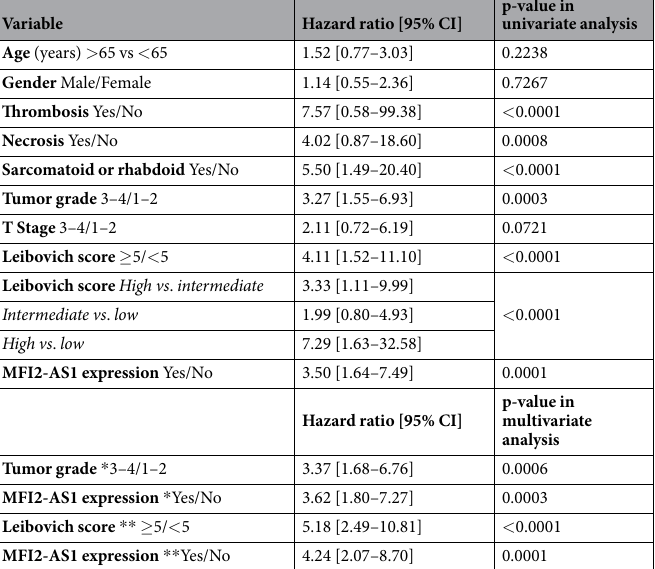
Table 2. Hazard ratio for disease-free survival according to patient and tumor characteristics. * Multivariate analysis according to MFI2-AS1 expression, T stage and grade. ** Multivariate analysis according to MFI2-AS1 expression and Leibovich